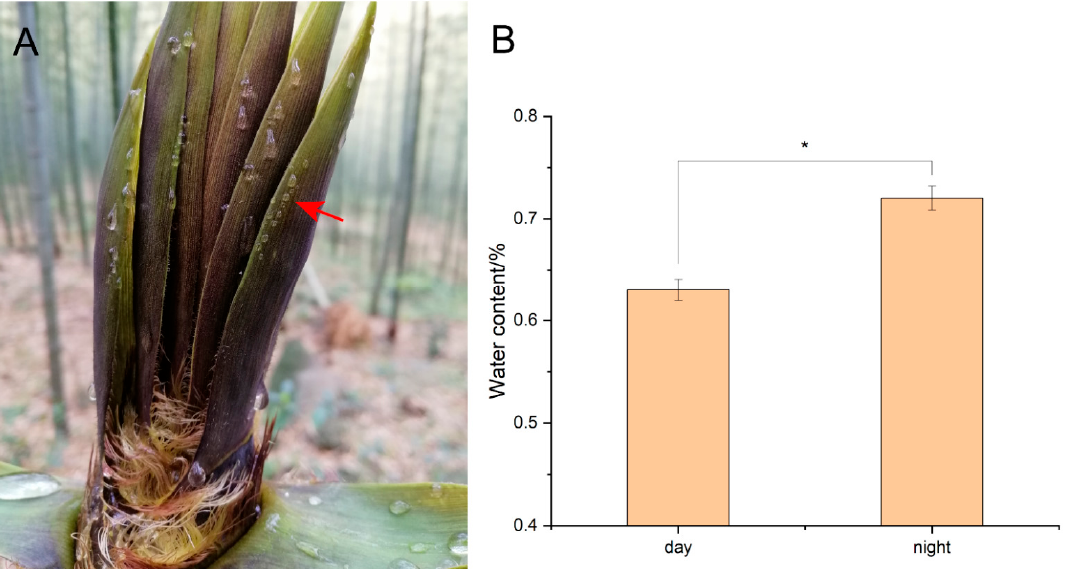
Figure 2. ( A ) Guttation liquid on edge of a bamboo sheath blade. The red arrow points to the location of guttation droplets; ( B ) Sheath blade water content during the day and night; the asterisk indicate a different significance, p < 0.05. Table 1. Changes the average of guttation volume with temperature and humidity.